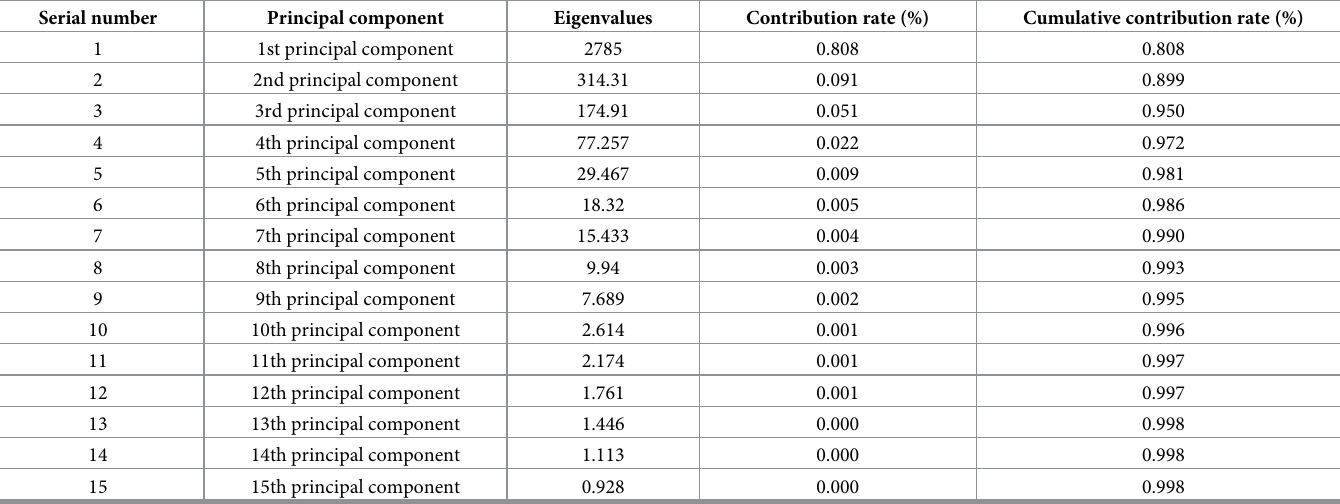
Table 1. Principal component eigenvalues, contribution rate and cumulative contribution rate of the mid-infrared spectral data of Cornus officinalis